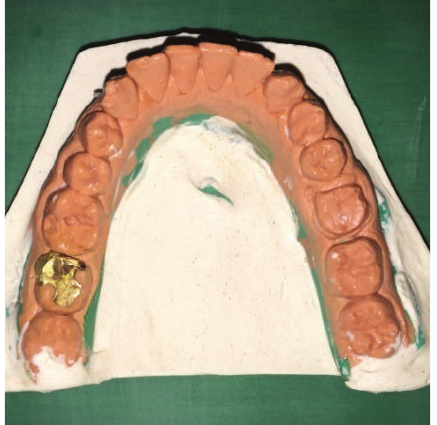
Figure 17: Mesiobuccal cusp in tooth 37 removed.